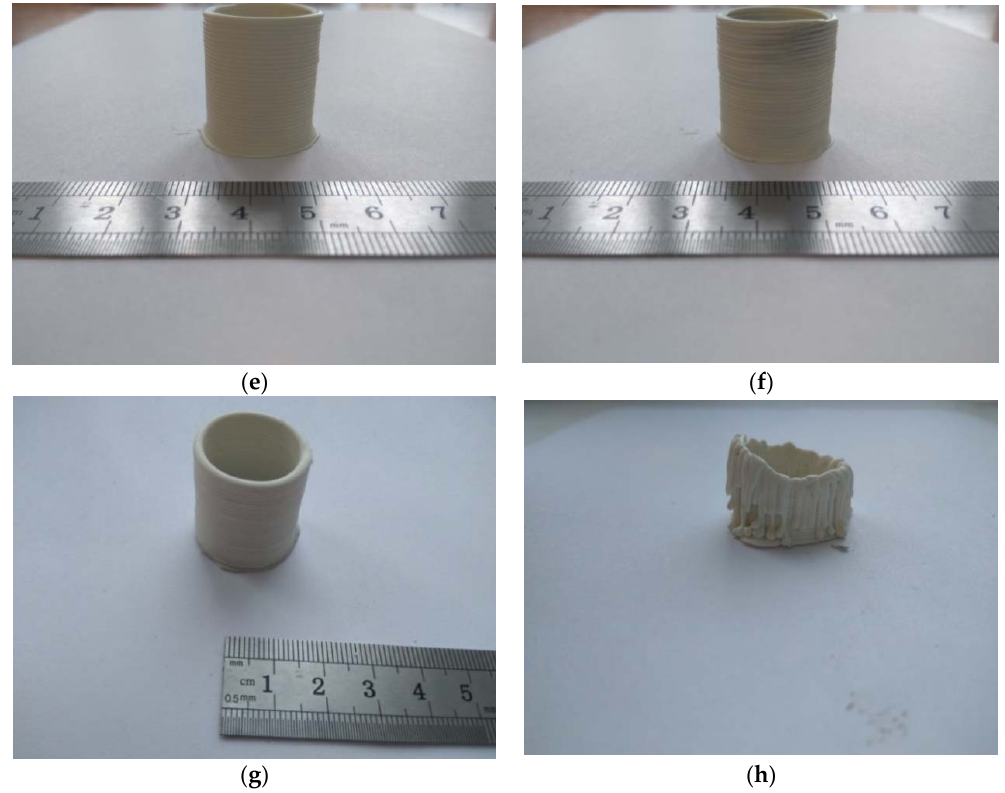
Figure 5. Images of the printing process of ceramic samples at a constant printing speed and using different temperatures for the hot zone of the movable head. ( a ) Sample No. 1: Temperature 60 ◦ C, wall thickness 3 mm; ( b ) Sample No. 2: Temperature 61 ◦ C, wall thickness 3 mm; ( c ) Sample No. 3: Temperature 62 ◦ C, wall thickness 3 mm; ( d ) Sample No. 4: Temperature 63 ◦ C, wall thickness 3.15 mm; ( e ) Sample No. 5: Temperature 64 ◦ C, wall thickness 3.6 mm; ( f ) Sample No. 6: Temperature 65 ◦ C, wall thickness 3.7 mm; ( g ) Sample No. 7: Temperature 66 ◦ C, wall thickness 3.9 mm; and ( h ) Sample No. 8: Temperature 67 ◦ C.